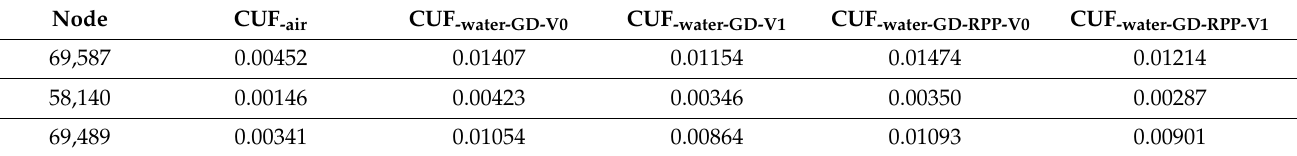
Table 9. Cumulate fatigue usage factor of the divider plate in a steam generator. Node CUF